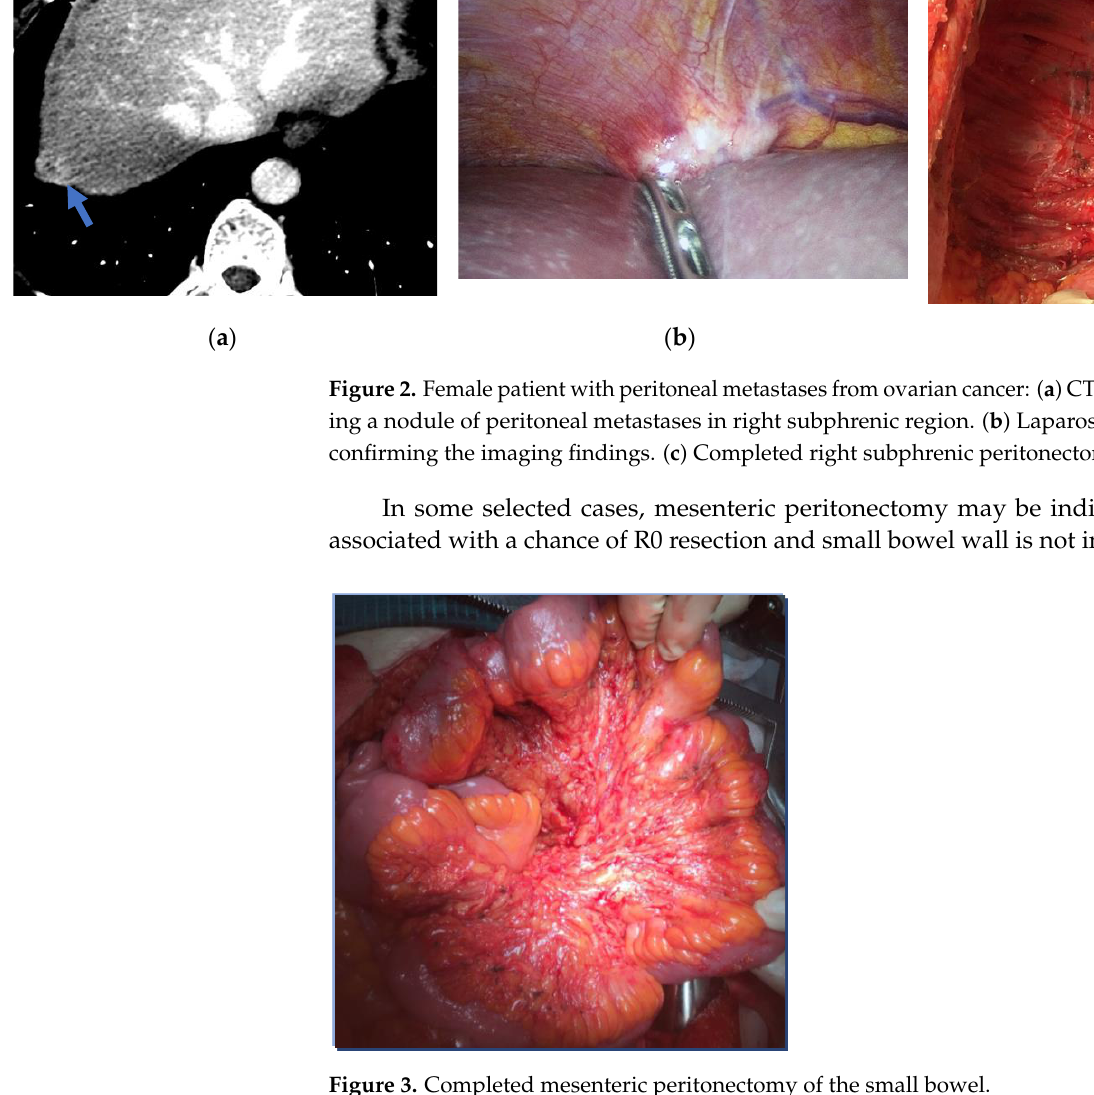
Figure 3. Completed mesenteric peritonectomy of the small bowel.